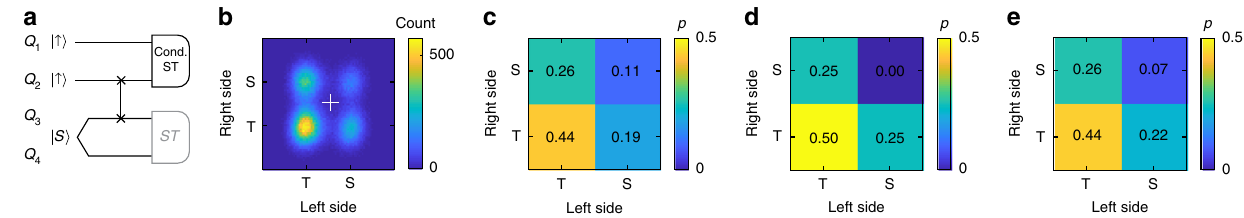
Fig. 2 Conditional teleportation of a classical spin state. a Quantum circuit to teleport a state "j i from qubit 1 to qubit 4. The conditional singlet – triplet measurement on qubits 1 and 2 induces teleportation, and the gray singlet – triplet measurement of the right pair veri fi es teleportation. b Experimentally measured probability distribution for 65,536 single-shot realizations of the teleportation sequence in a . The white cross indicates the threshold used to calculate probabilities. c Extracted probabilities p from the distribution in b . d Simulated probabilities computed neglecting any errors. e Simulated probabilities accounting for readout errors, state preparation errors, charge noise, and hyper fi ne fi elds. All probabilities are rounded to the